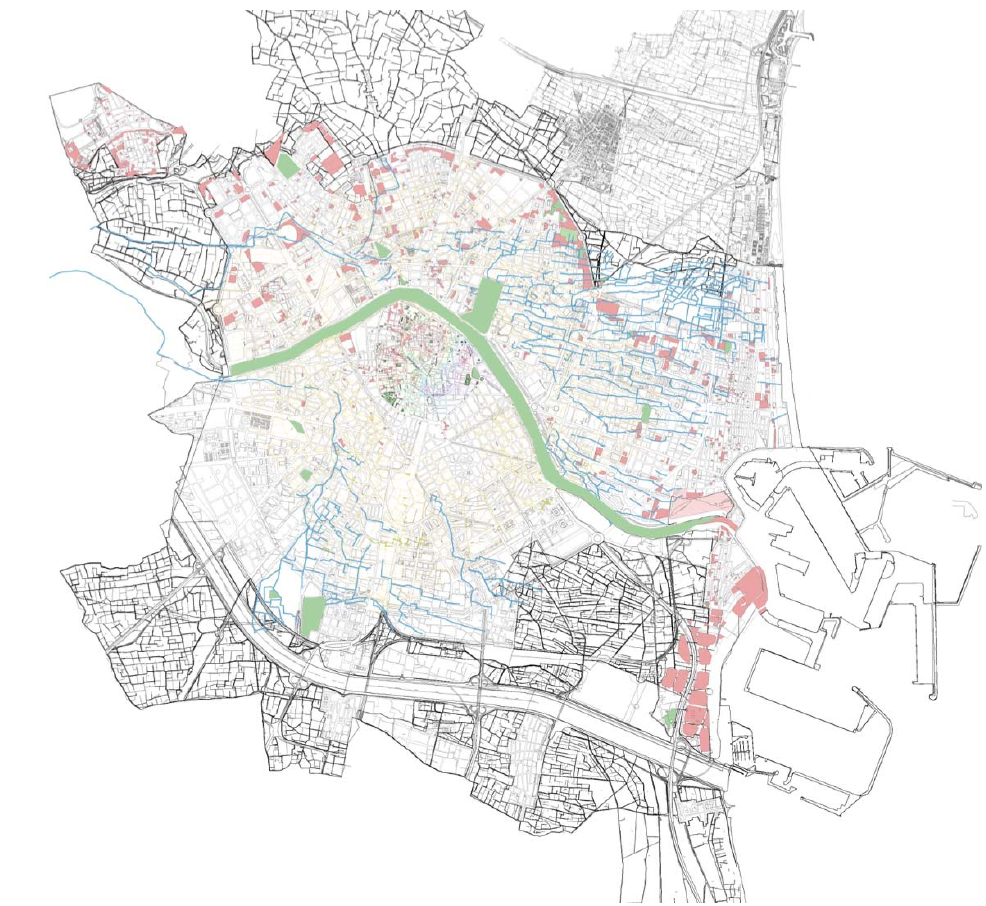
Figure 26. The city with the present contour lines, unoccupied plots and green areas with lines of irrigation canals from the cadaster 1946.